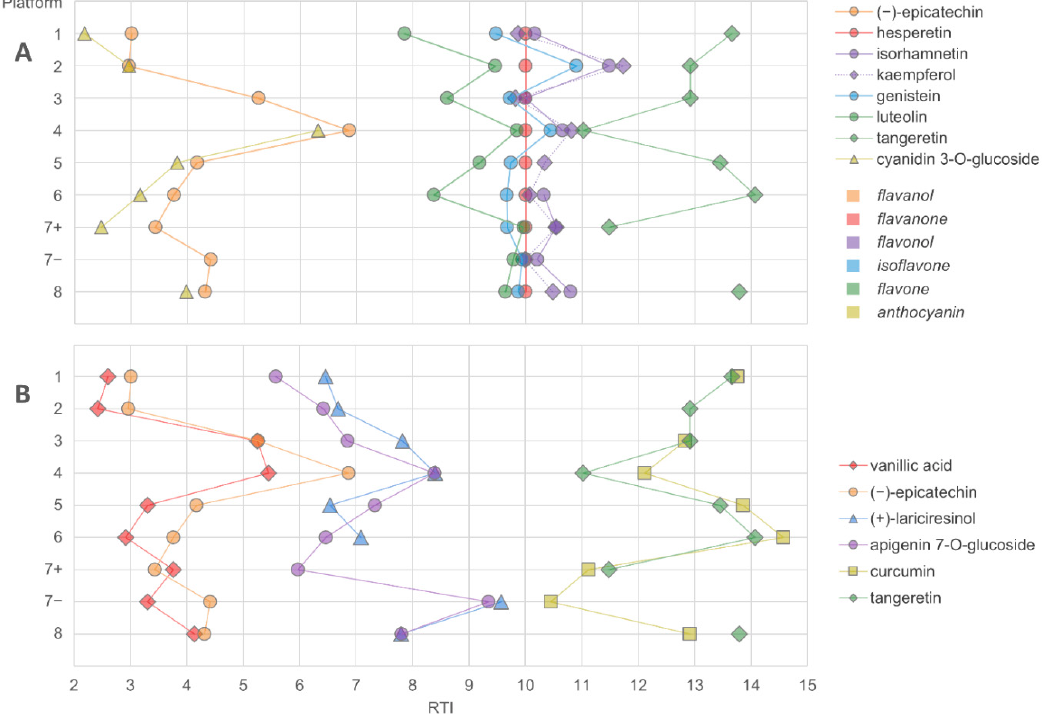
Figure 6. The elution order of flavonoids ( A ) and three pairs of closely eluting compounds representing different compound classes ( B ) in LC–MS platforms using a C 18 reversed-phase column. The retention times were normalized based on gallic acid and hesperetin (RT N for hesperetin = 10).